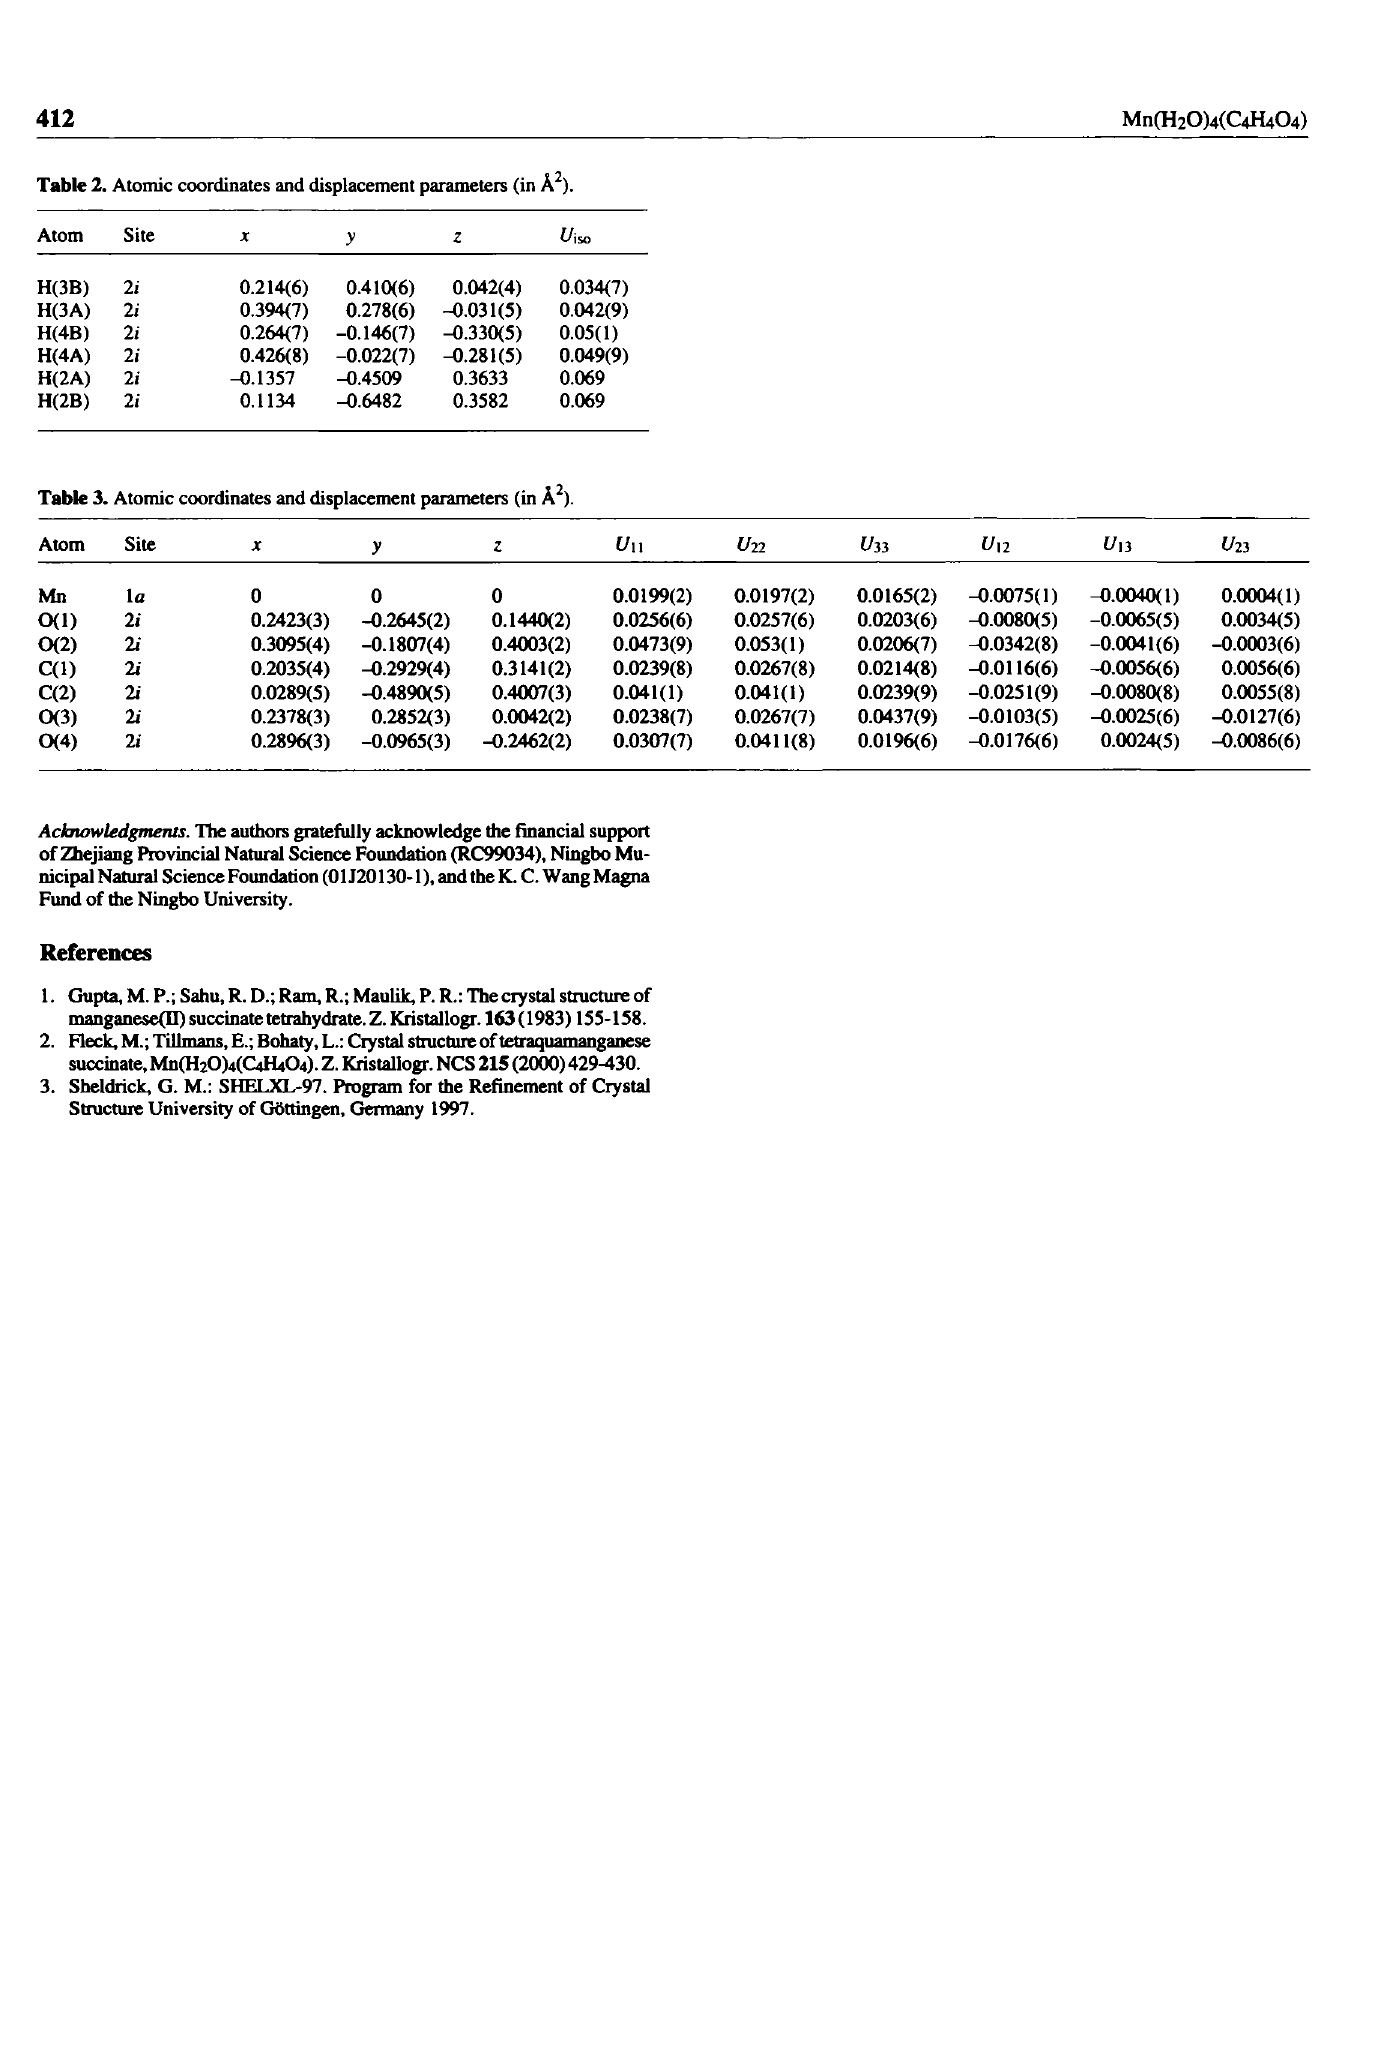
Table 3. Atomic coordinates and displacement parameters (in Â 2